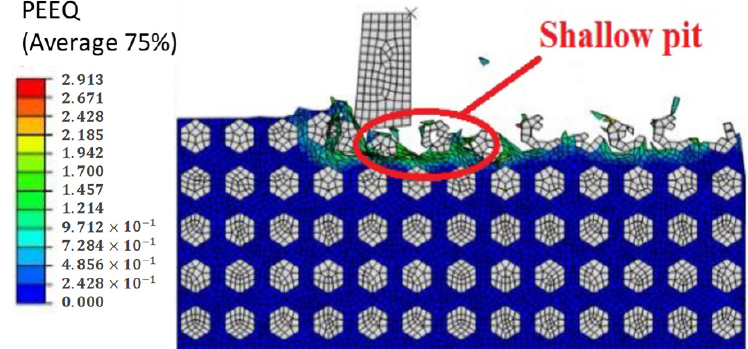
Figure 19. Simulation results of shallow pits on a machined surface.